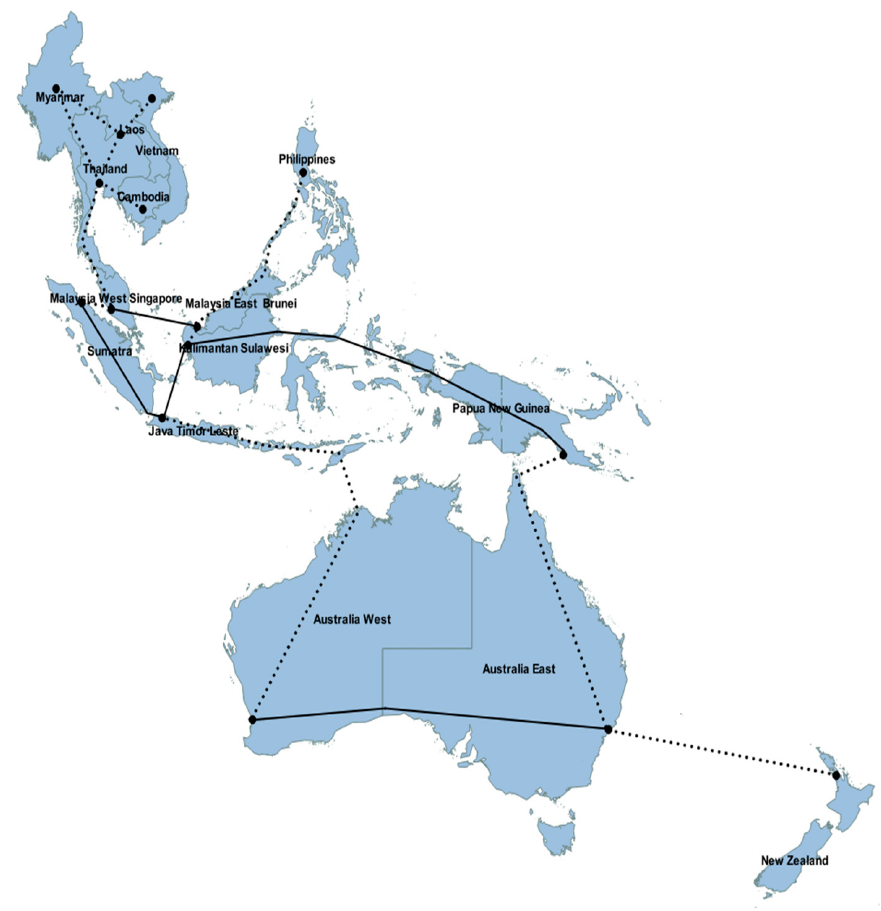
Figure 3. Southeast Asian subdivision and HVDC grid configuration.